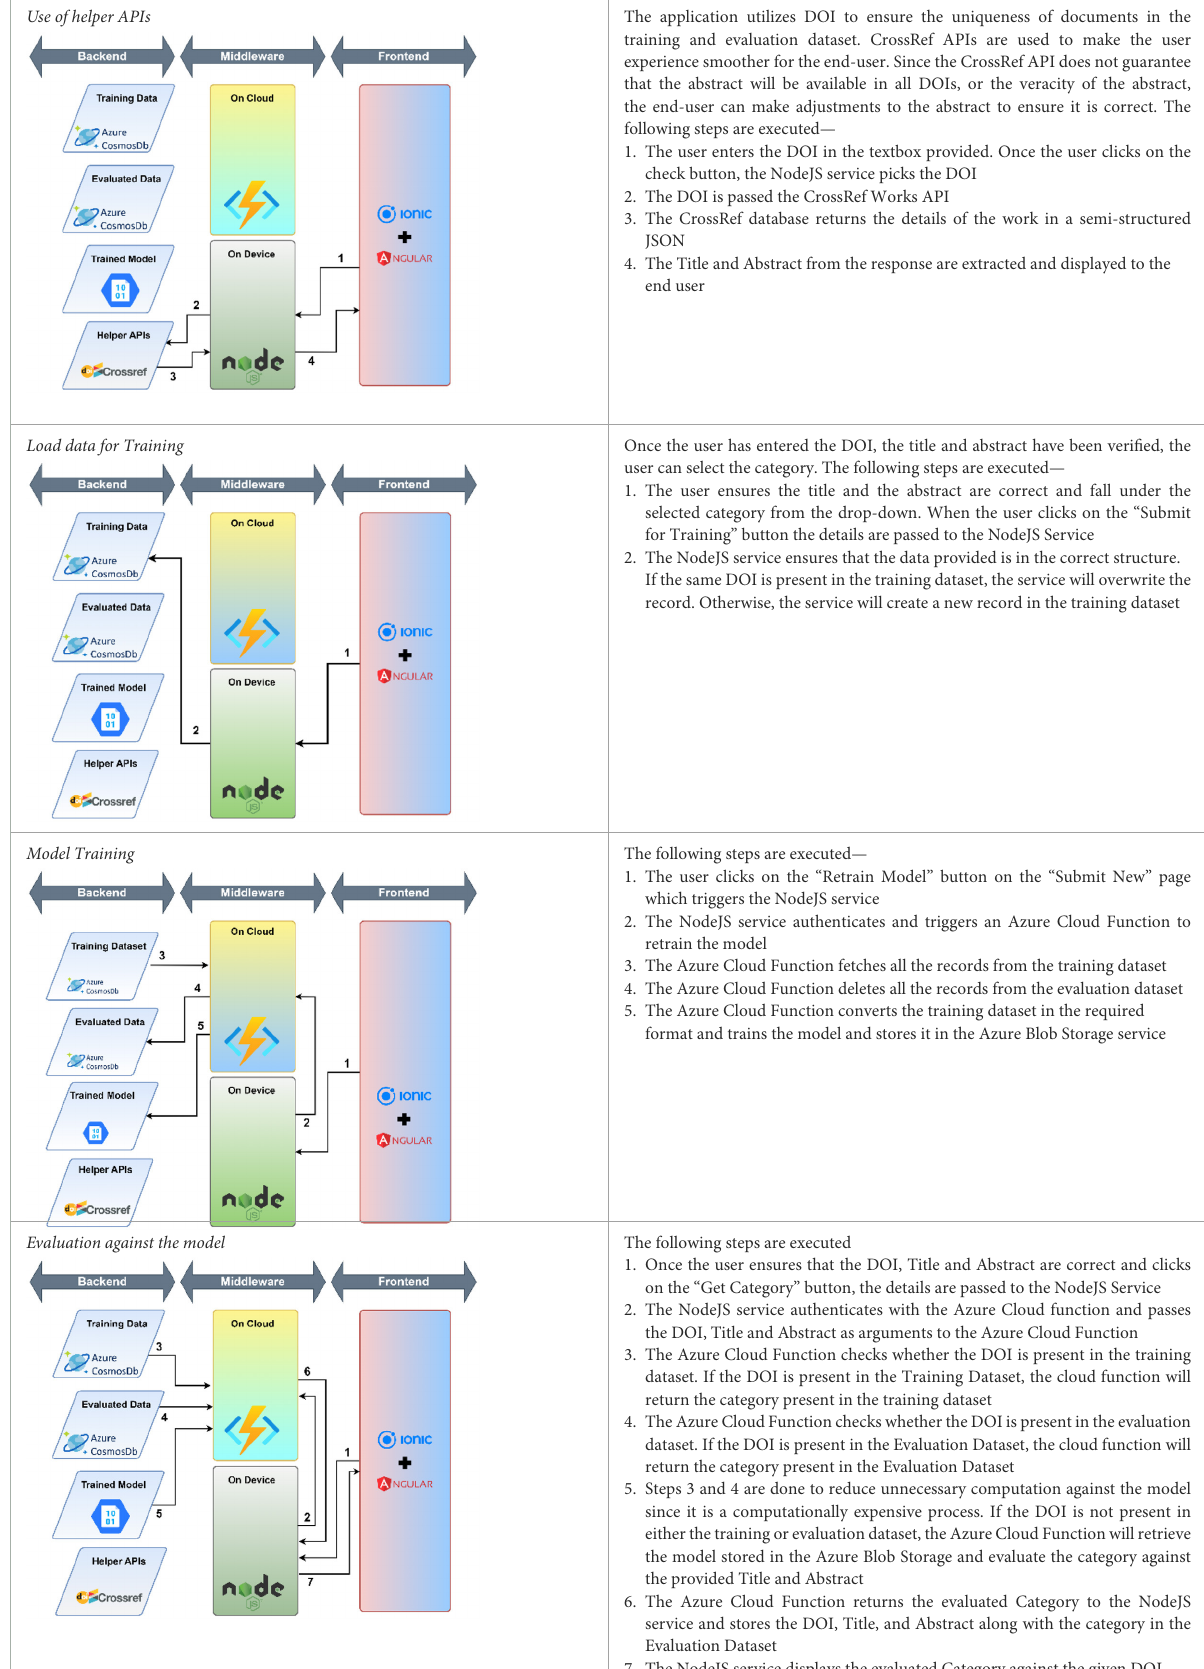
TABLE 3 A detailed workflow of the developed user interface. Use of helper